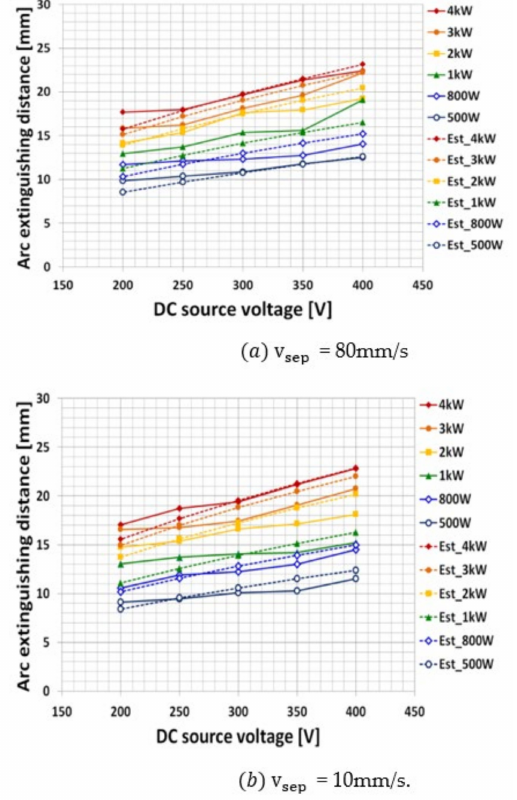
Figure 10. Arc extinction distance experimental value curve and estimated curve: Power supply voltage equal or larger than 200